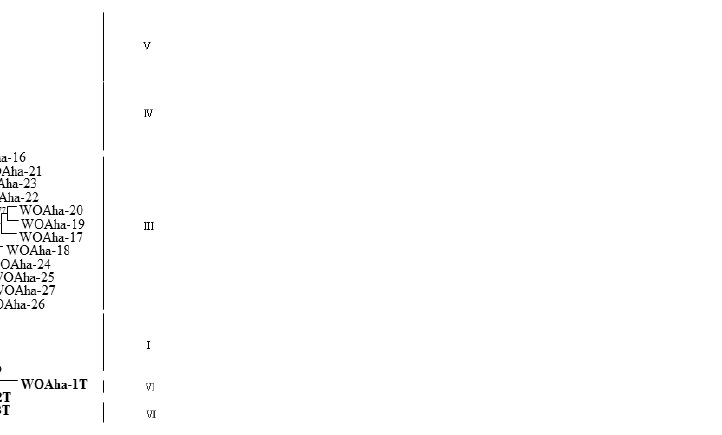
Figure 2. Maximum likelihood tree for phage WO types of A. hakonensis based on orf7 sequences. WOAha-X refers to the phage WO types, “T” indicate the full length sequence of orf7 . Numbers above and below branches are bootstrap values computed from 1000 replications.